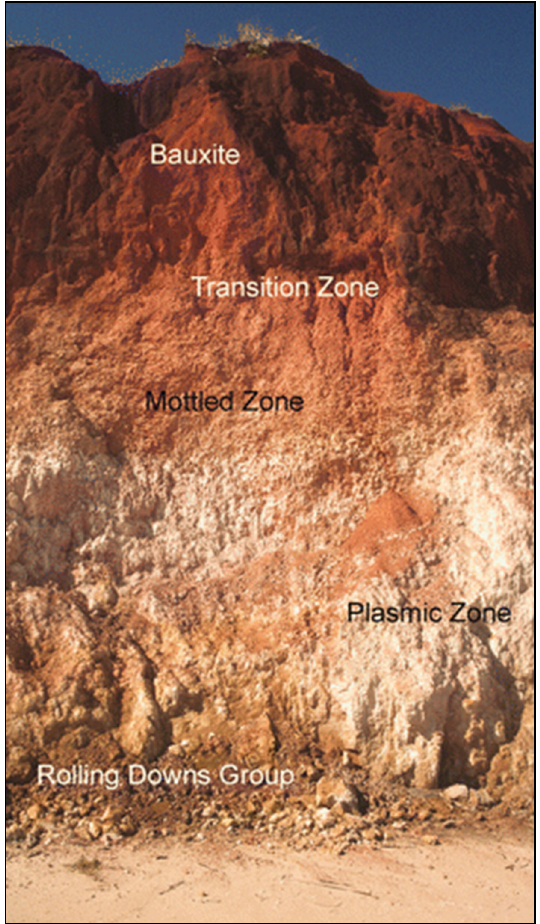
Figure 3. Regolith zone examples from the Weipa area. The image was reproduced from reference [27]. ence